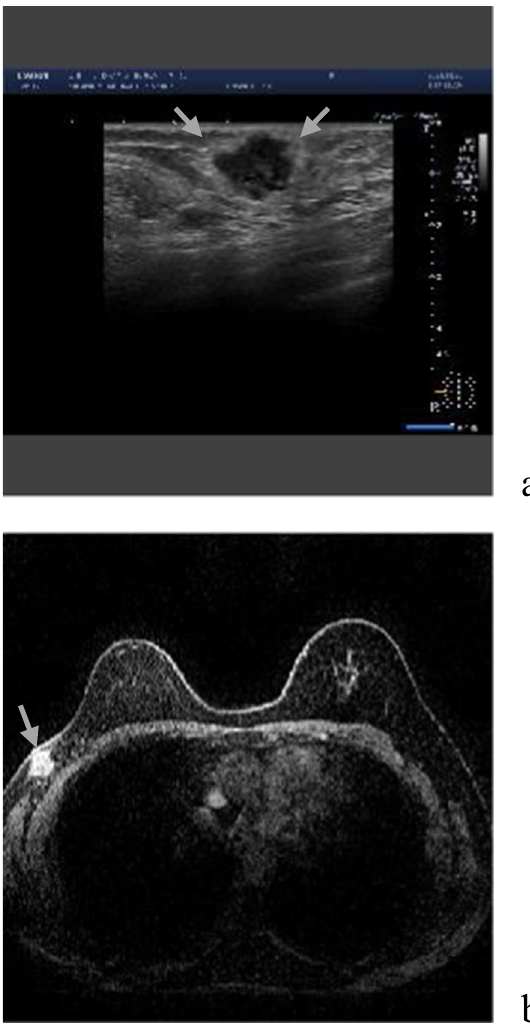
Fig. 2 Ultrasonography and magnetic resonance imaging of the tumor. Ultrasonography scans revealed a 21.3-mm tumor in breast ( a ). Magnetic resonance imaging revealed 16 mm irregular geometries close to the skin ( b )